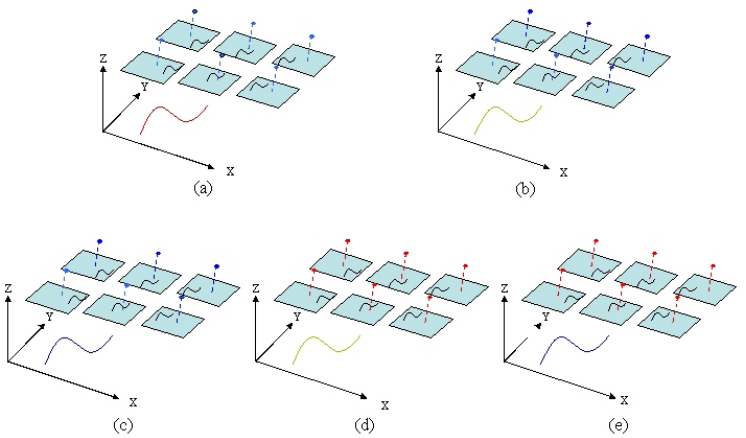
Figure 3. Different examples. (a) Known EOPs with tie splines, (b) Known EOPs with partial control splines, (c) Known EOPs with full control splines, (d) Unknown EOPs with partial control splines, and (e) Unknown EOPs with full control splines. (Red: Unknown parameters, Green: Partially fixed parameters, Blue: Fixed